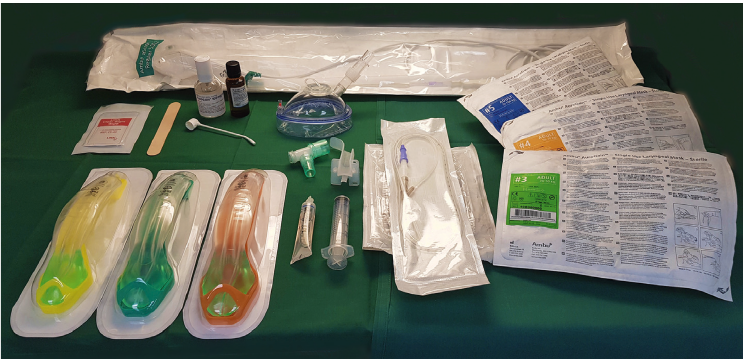
Figure 3: Drawer 2 (plan B) oxygenation via a supraglottic airway device. Note that the videobronchoscope is not included in the drawer but attached to the side of the trolley.